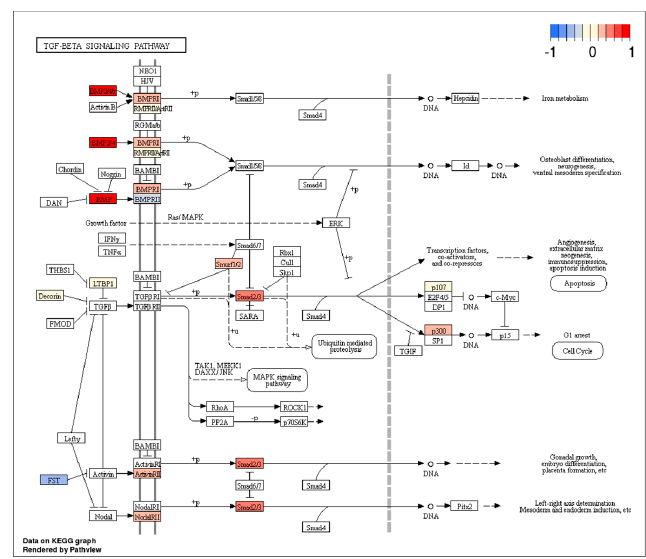
Figure 3. The transforming growth factor- β (TGF- β ) signaling pathway with marked expression levels of deregulated genes. Arbitrary signal intensity acquired from microarray analysis is represented by colors (red, higher; blue, lower expression).